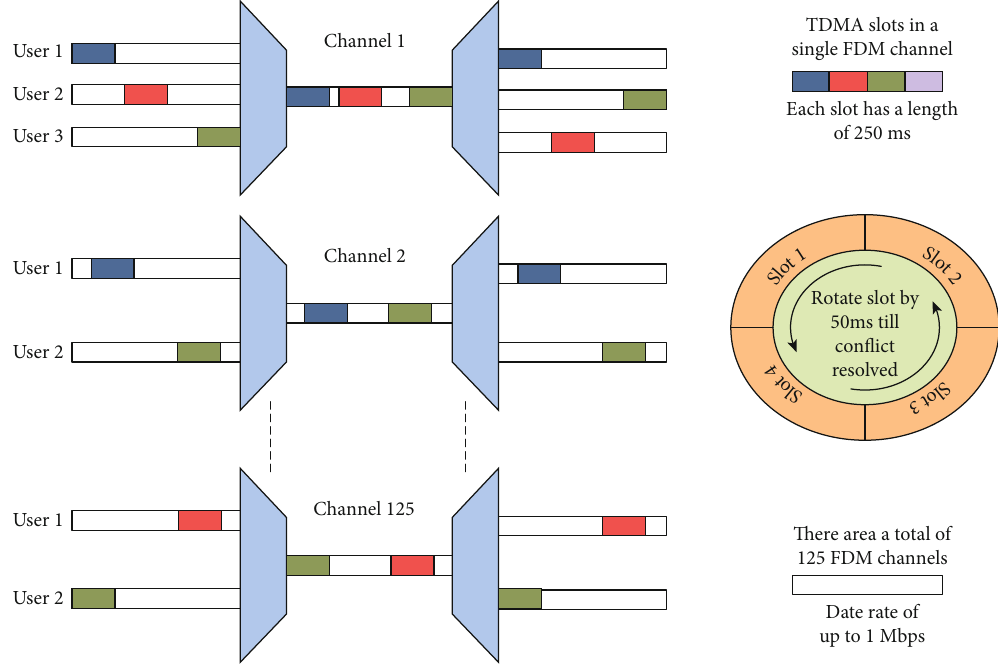
Figure 6: The customized protocol for multiple users in crowd